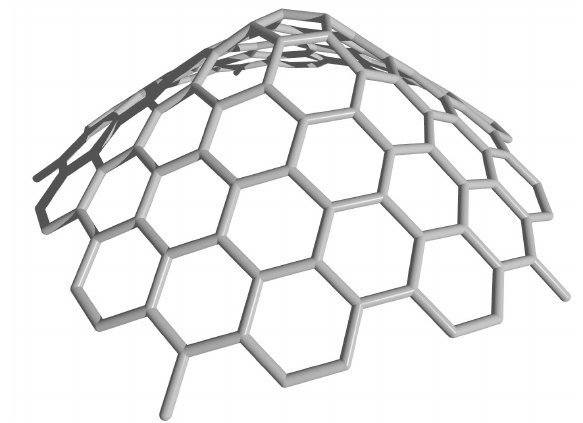
Figure 4. Cone constructed from the rolled-up model with n =